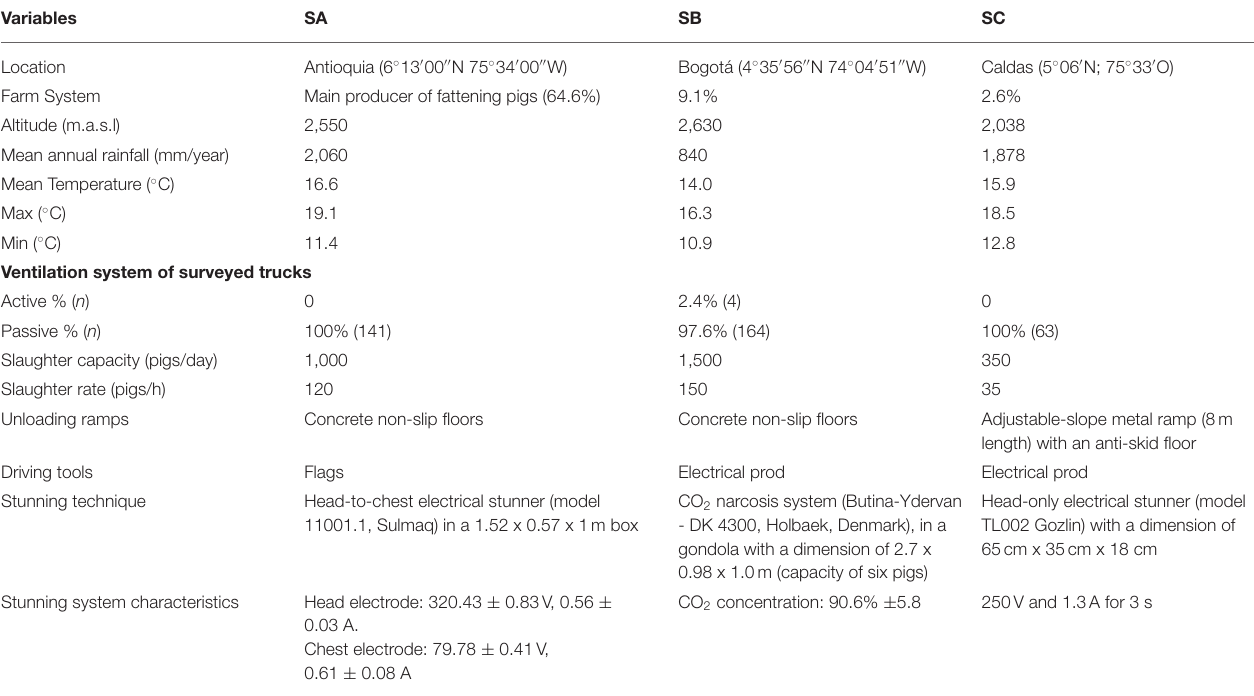
TABLE 1 | Characteristics of the three slaughterhouses evaluated in this